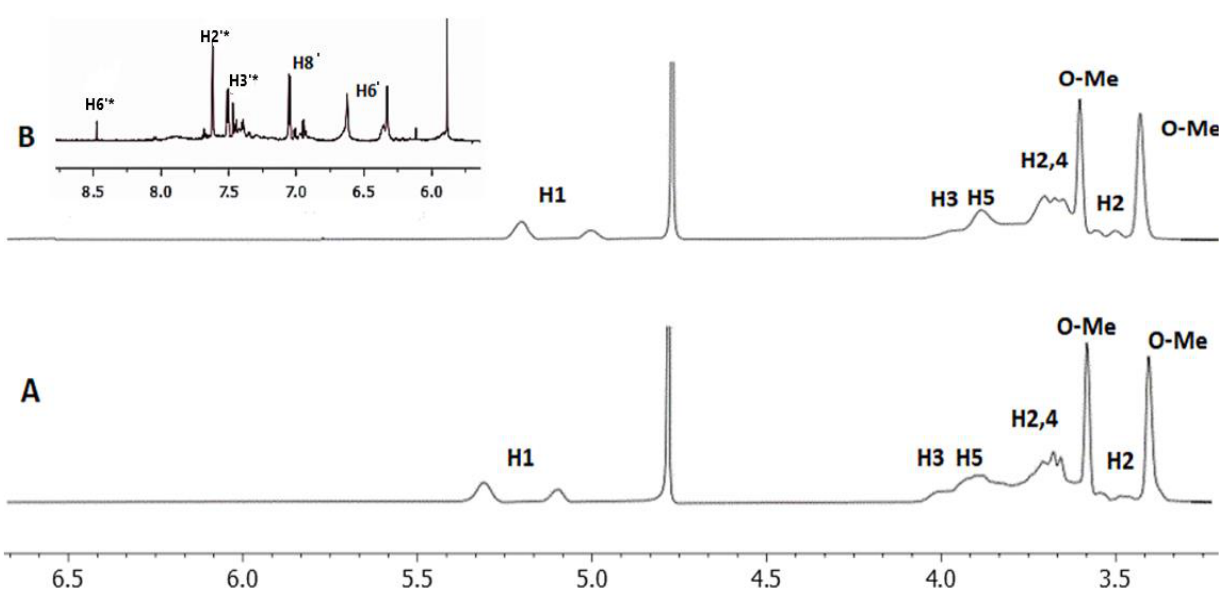
Figure 2. The 1 H NMR of ( A ) 2,6Me- β -CD ( B ) complex of QUE with 2,6Me- β -CD. The spectra were obtained at 25 °C in D 2 O. Table 1. 1 H NMR chemical shifts for 2,6Me- β -CD and the lyophilized complex, in D 2 O at 25 ◦